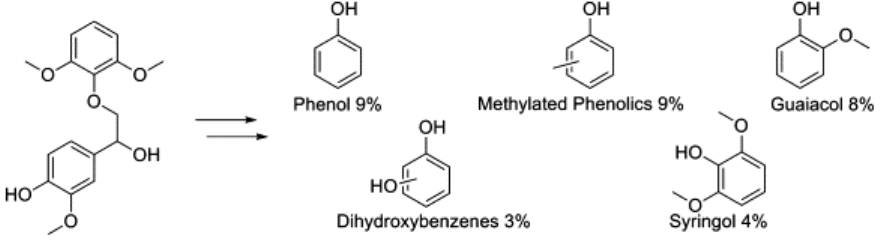
Figure 9. The reaction mechanism for the HDO of guaiacol. Reproduced from reference [83].